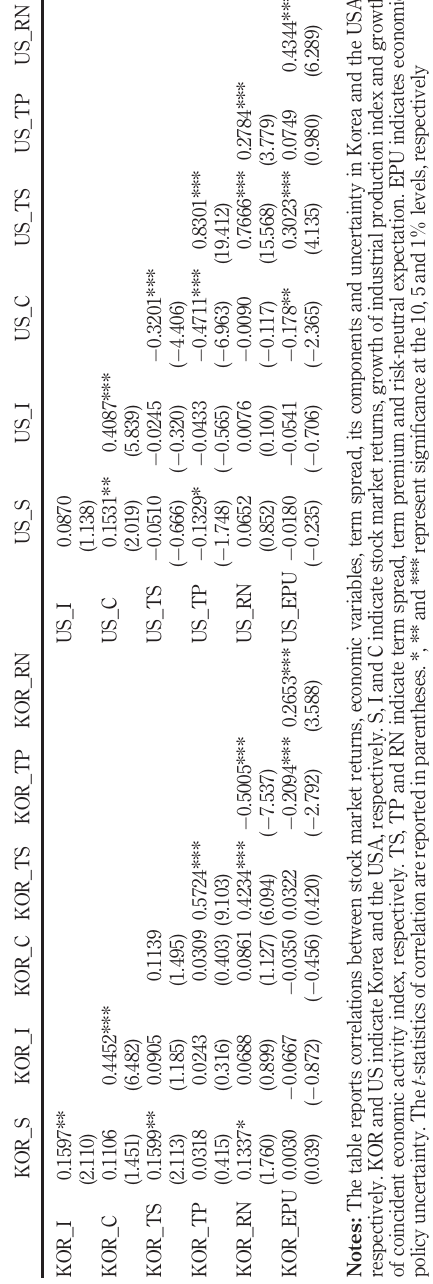
Table 3. Correlation of stock market returns, economic variables, term spread, its components and